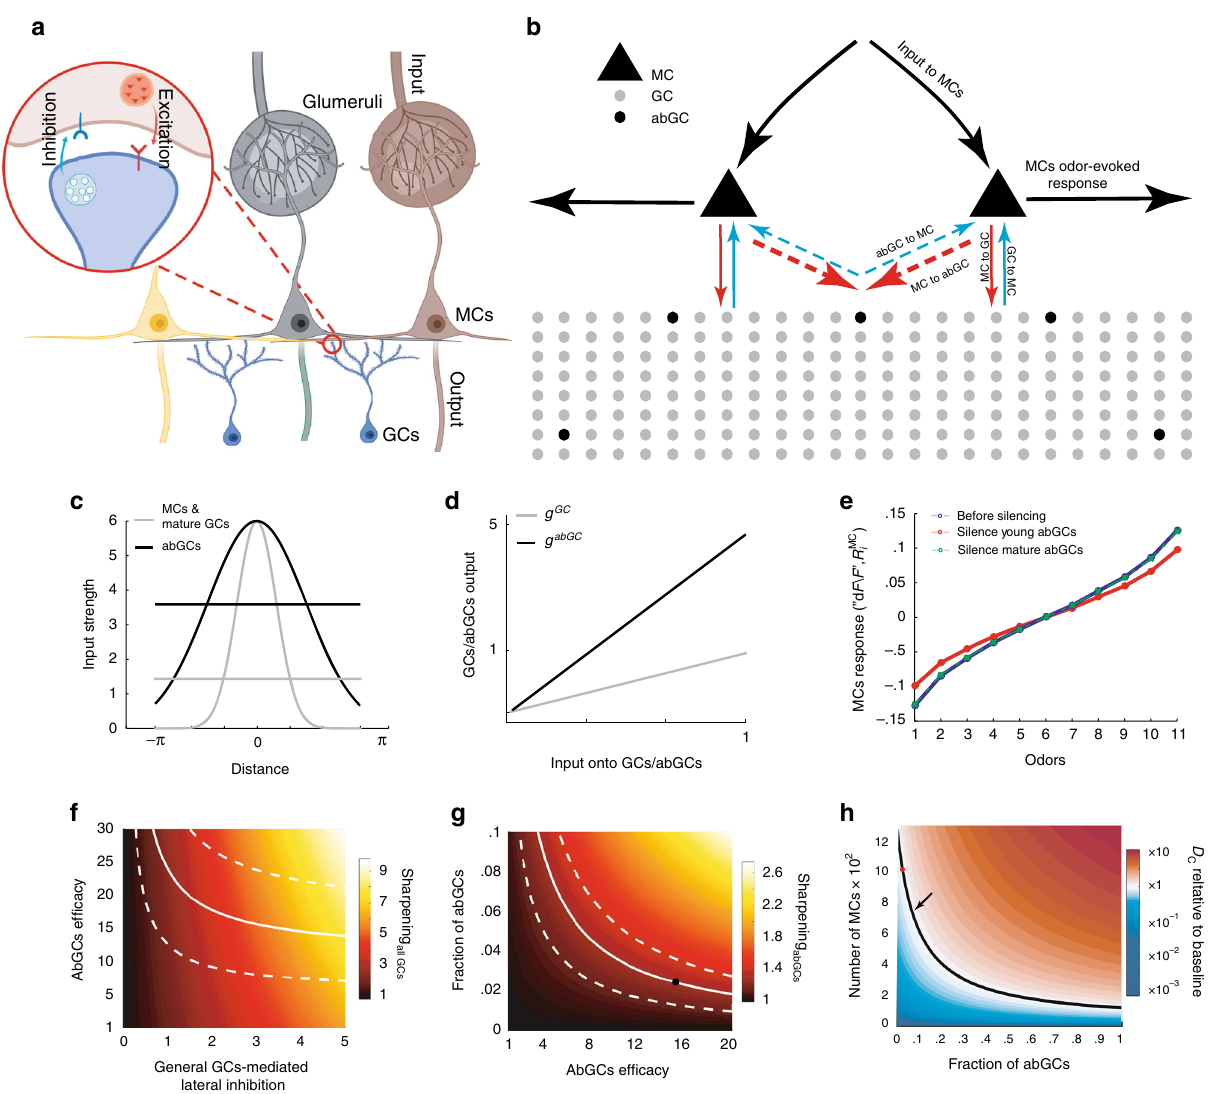
Fig. 6 A model of the OB suggests a mechanism by which abGCs increase information in MCs. a Schematics of MCs and GCs/abGCs in the olfactory bulb. b A schematic illustration of the model. Blue arrows denote inhibition and red excitation. c Connection strength between MCs and GCs/abGCs as a function of spatial proximity. Horizontal lines display the average connectivity based on connectivity width and peak. abGCs have broader, more promiscuous input connectivity than mature GCs. “ abGCs input broadness ” is the ratio between abGCs and GCs average connectivity. d Input – output functions for both GCs and abGCs. “ abGCs excitability ” is the ratio between abGCs and GCs input – output slope. e Silencing young abGCs (2.5% of total GCs) quenches MC responses (red curve, cf. Fig. 3e). Silencing the same amount of mature GCs had no effect (green curve). f Sharpening of MC tuning due to entire GC network (Sharpening allGCs , i.e., the ratio of MC output tuning to input tuning) as a function of both GC-mediated MC lateral inhibition and by constraining the model to fi t our data. Dashed lines — con fi dence borders (see “ Methods ” ). g Sharpening abGCs as measured in our data. Dashed lines — con fi dence borders (see “ Methods ” ). Black dot represents the parameters used in our model. h Number of MCs needed to maintain a fi xed level of discrimination between odors (Chernoff distance; see “ Methods ” ) as a function of the proportion of young abGCs. Red/blue gradients represent increased/decreased discriminability, respectively. The red dot represents our baseline model network (1000 MCs and 2.5% (2500) abGCs). Black line — fi xed value of discrimination in our model network ( ≈ 30 D c ), for different MCs/abGCs ratios. Arrow — proportion of abGCs (7.5%) that would achieve half the potential reduction in the number of MCs that an all-abGC network would achieve. a was created with